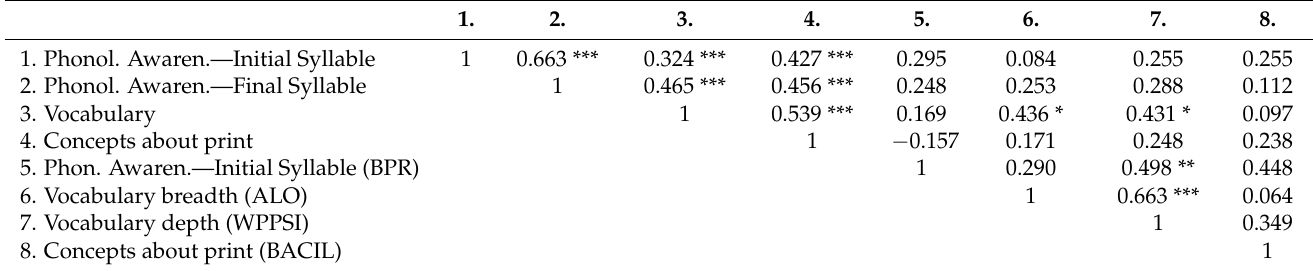
Table 4. Correlation matrix depicting correlations between all study variables (pre-K group).